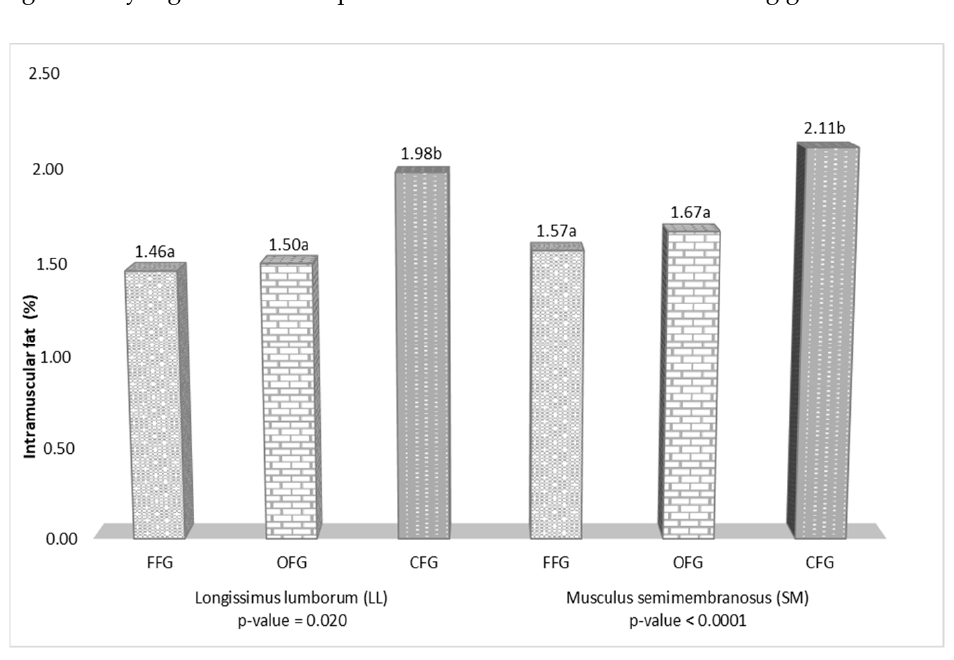
Figure 4. Content of cholesterol (mg/100 g meat) in the meat of red deer from the three feeding grounds (FFG—forest feeding ground; OFG—organic feeding ground; CFG—conventional feeding ground). For each muscle, means in the same row sharing different letters are significantly different.